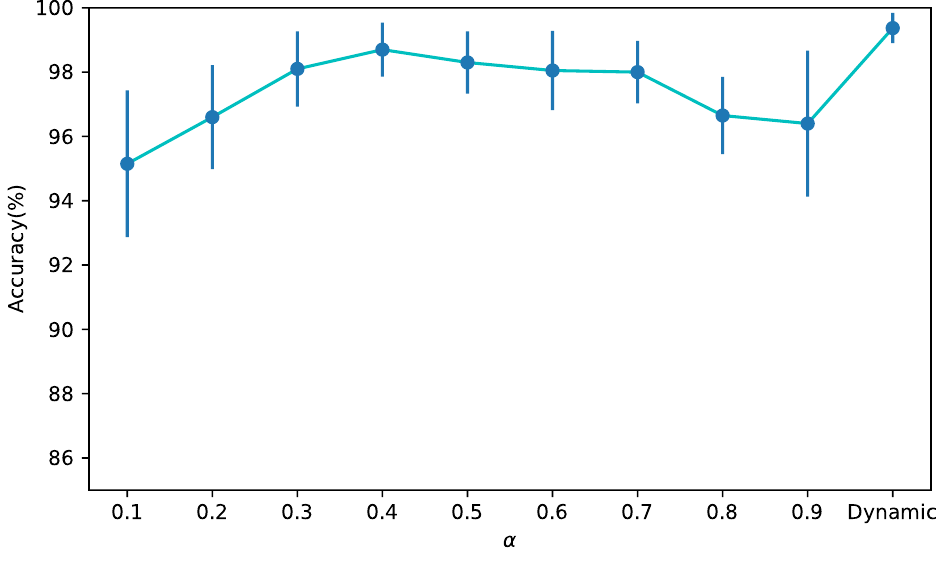
Figure 5. Accuracies of DSFEAE with stable α and DSFEAE-DF.